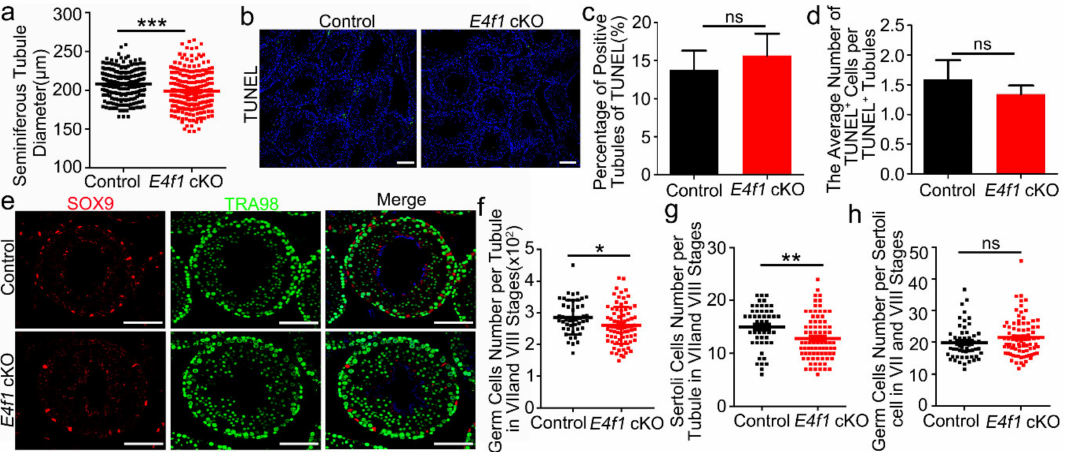
Figure 4. Loss of E4f1 resulted in decreased Sertoli cell population. ( a ) Quantification of seminiferous tubules diameter per tubule of controls and E4f1 cKO male mice. n = 3. ( b ) Immunofluorescence staining for TUNEL in cross-section from controls and E4f1 cKO male mice. Scale bar = 100 µ m. ( c ) The percentage of TUNEL positive tubules in testes of controls and E4f1 cKO male mice. n = 3. ( d ) Quantification of TUNEL positive cells per TUNEL positive tubules in testes of controls and E4f1 cKO male mice. n = 3. ( e ) Immunofluorescence staining for SOX9 and TRA98 in cross-sections of testes from controls and E4f1 cKO male mice. Scale bar = 100 µ m. ( f ) Quantification of germ cells per tubule in VII and VIII stages of the testes from controls and E4f1 cKO male mice. n = 3. ( g ) Quantification of Sertoli cells per cord in VII and VIII stages of testes from controls and E4f1 cKO male mice. n = 3. ( h ) Quantification of germ cells per Sertoli cell in VII and VIII stages of the testes from controls and E4f1 cKO male mice. n = 3. *, ** and *** denotes significantly di ff erent at p < 0.05, p < 0.01, and p <